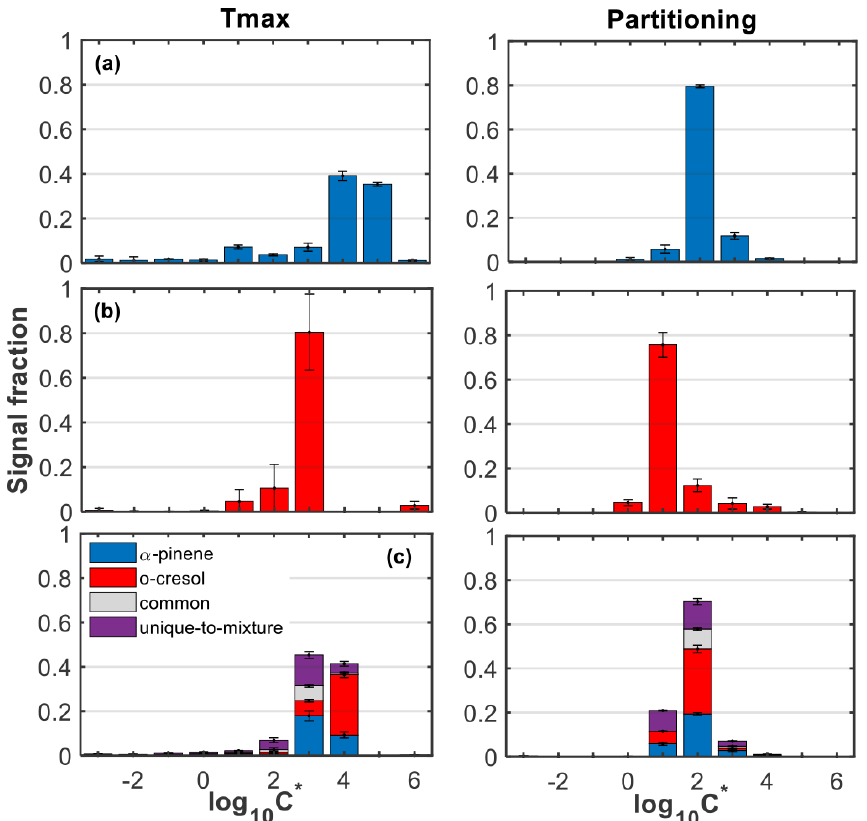
Figure 3. Average ( ± 1 σ ; n = 2) volatility distributions as a function of the FIGAERO-CIMS total particle-phase signal in the (a) α -pinene, (b) o -cresol, and (c) mixed VOC systems using the calibrated T max (left panels) and partitioning approaches (right panels). The bars in the mixed system are separated to show the contributions from the products of either precursors, the common ones found in all systems, and those that were found to be unique in the